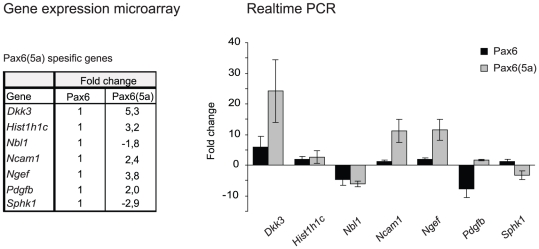
Real time quantitative PCR shows that Dkk3, Ncam1, Ngef and Sphk1 are strongly regulated by Pax6(5a).Primers were designed for some of the genes showing differential expression only in the FlpIn-3T3 Pax6(5a) cell line (Dkk3, Hist1h1c, Nbl1, Ncam1, Ngef, Pdgfb, Sphk1). Real time quantitative PCR was performed as described in Fig. 4. The fold change values obtained for the same genes in the Illumina gene expression microarray are given in the table to the left of the graph for comparison.